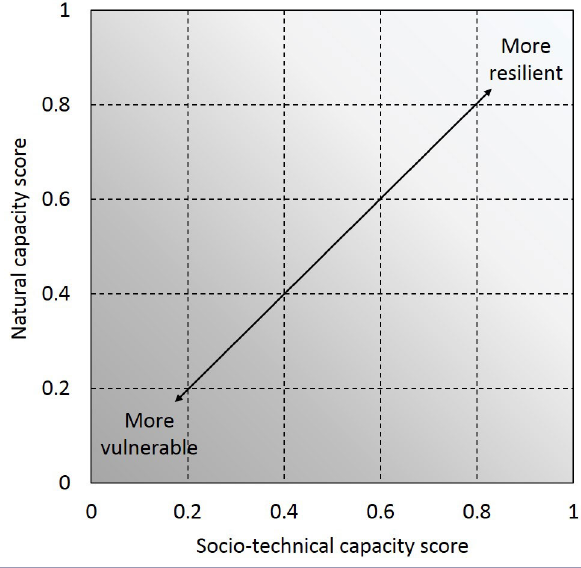
Fig. 4 . Surface for assessment of system resilience based on its hypothesized relationship with the combination of socio- technical and natural capacity scores (the lighter the shading, the more resilient the system